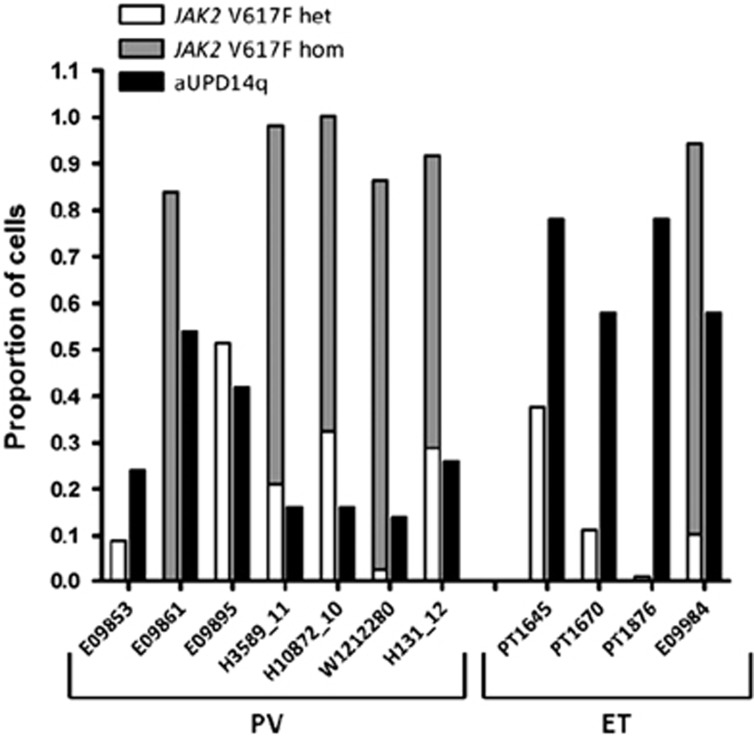
Proportions of cells positive for JAK2 V617F and aUPD14q in cases with both abnormalities. Black bars indicate cells positive for aUPD14q; grey bars indicate homozygous JAK2 V617F mutant cells and white bars indicate heterozygous JAK2 V617F mutant cells.